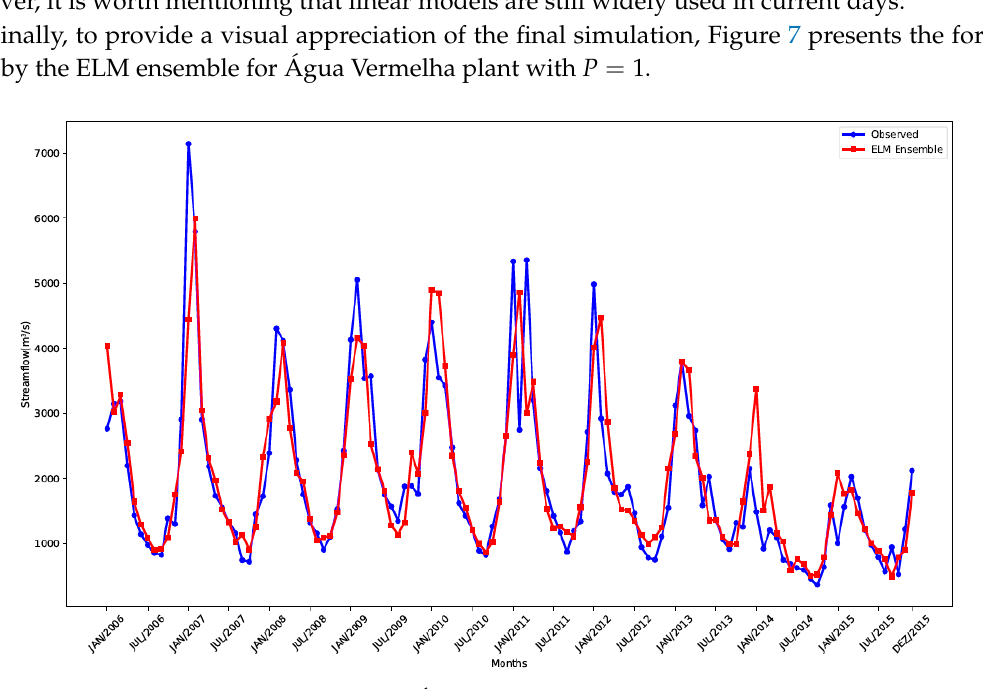
Figure 7. Best predicted to Á gua Vermelha of 2006 at 2015 and 𝑃 = 1 .